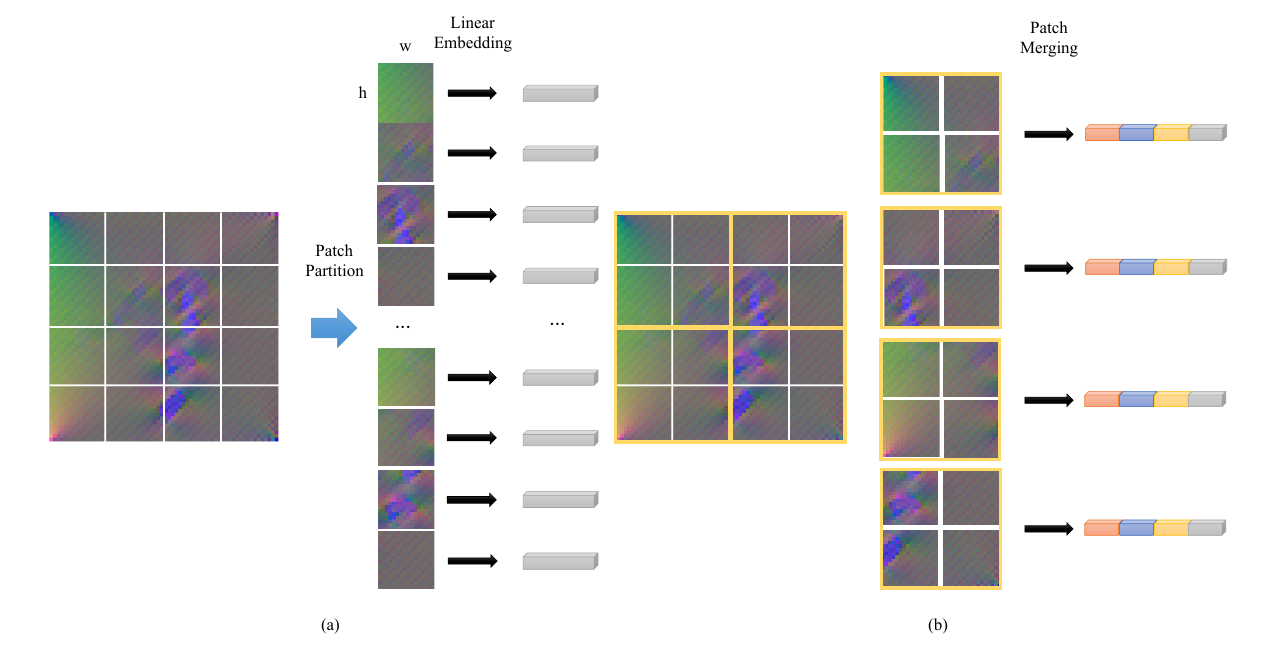
Figure 3. Patch block and patch merging: ( a ) Patch block: splits the strain field map and embeds them. ( b ) Patch merging: concatenates the patch and re-embeds. Patch merging merges the patches of the previous layer feature map, as shown